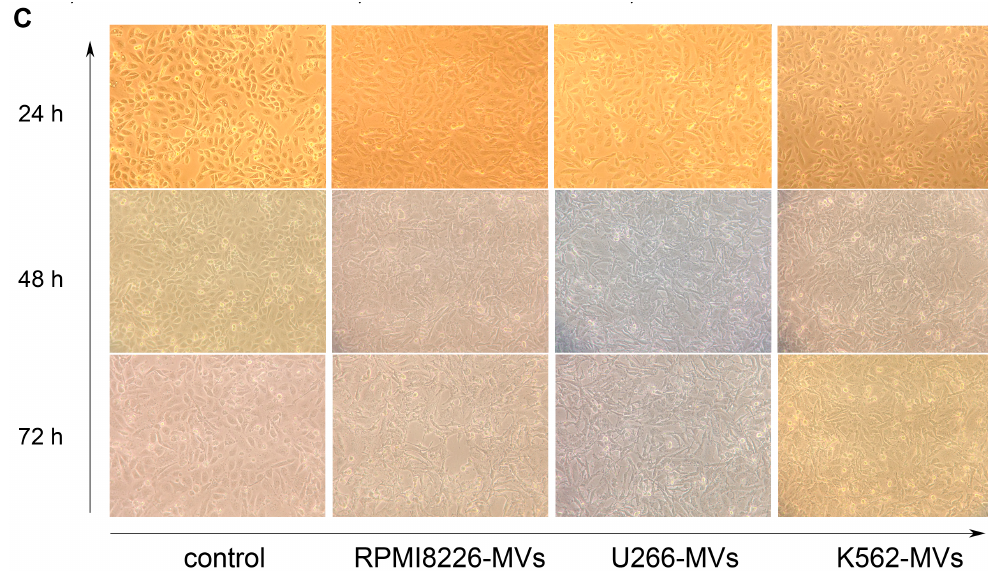
Figure 2. Inhibited viability and induced apoptosis in human kidney-2 cells (HK-2 cells) by MM-MVs. ( A ) HK-2 cells (10 5 /mL) were treated with various concentrations of MM-MVs and K562-MVs (1, 5, 10, and 50 µ g/mL) for 24, 48, and 72 h, respectively. The effects of MM-MVs on viability in HK-2 cells were determined with Cell Counting Kit-8 (CCK-8) assay. MM-MVs, but not K562-MVs, inhibited proliferation in HK-2 cells at the time points in a dose-dependent manner; ( B ) After 48 h, the effects of MM-MVs and K562-MVs on apoptosis in HK-2 cells were determined with FITC-annexin V-PI FCM analysis. MM-MVs, but not K562-MVs, induced apoptosis in HK-2 cells at 48 h in a dose-dependent manner. Representative FCM analysis of early and late apoptosis in HK-2 cells treated with MM-MVs and K562-MVs (10 µ g/mL) (top) and bar graphs for apoptosis rates (bottom); ( C ) The effects of MM-MVs on the morphology of the HK-2 cells treated with MM-MVs or K562-MVs (50 µ g/mL) were observed using an charge-coupled Nikon Coolpix 995 digital charge-coupled device (CCD) camera attached to a Nikon Diaphot inverted phase-contrast microscope (Nikon, Tokyo, Japan), Magnification: 100 × . * p < 0.05, ** p < 0.01, *** p < 0.001.